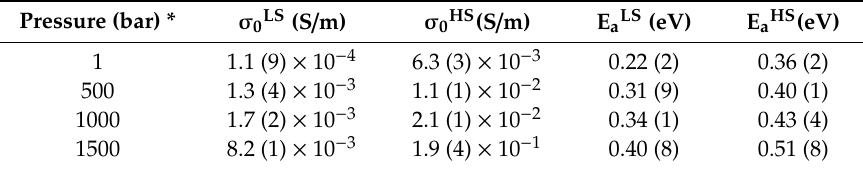
Table 1. Activation parameters of the AC conductivity (1 Hz) in the low spin (LS) and high spin (HS) states for sample S1